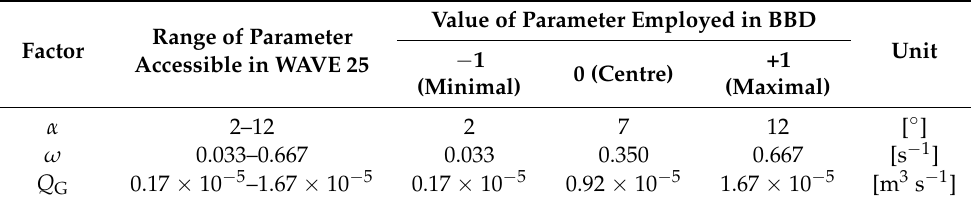
Table 1. Values of the operating parameters are recognized as independent factors employed in DoE-aided analysis based on